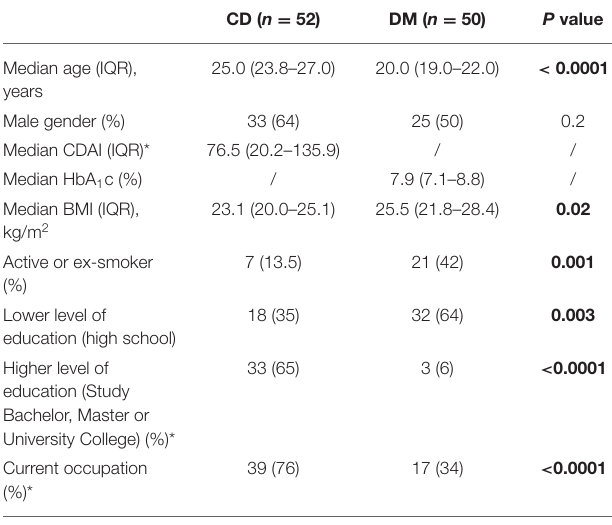
TABLE 1 | Baseline characteristics of CD and DM patients.